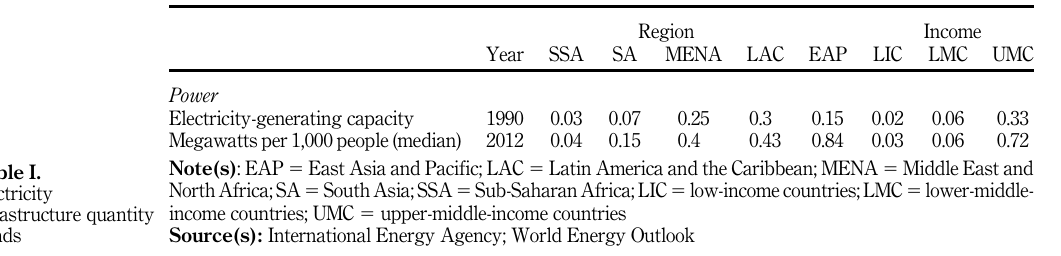
lowest road density among the developing regions under analysis. The analysis is shown in Table II below. Moreover, Sub-Saharan Africa is the only region where road density has declined over the past 20 years. The density of the railroad network is likewise low, at less than 0.002 km per